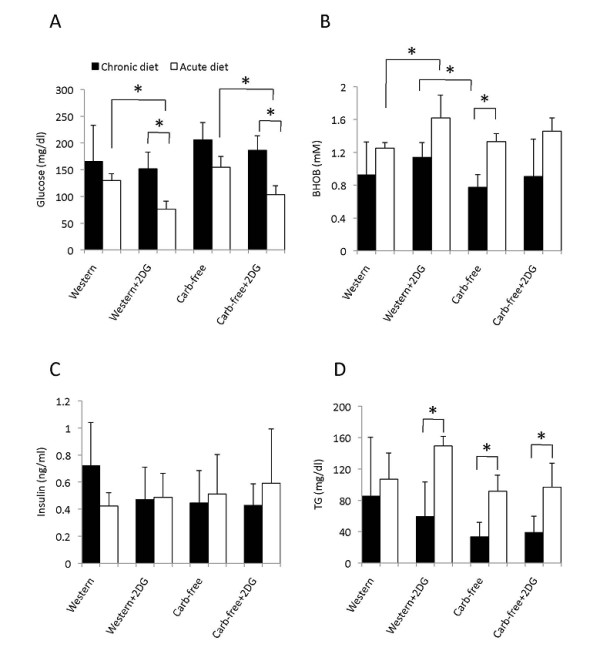
Systemic metabolic responses to diets and 2-DG. Sera obtained at sacrifice in fasted animals was analyzed for A) glucose, B) β-hydroxybutyrate (BHOB), C) insulin and D) triglyceride (TG). Chronic diet (black bars) indicates those that were treated for 14 weeks. Acute diet (open bars) indicates treatments for 4 days. Error bars represent SEM. *, p < 0.05.